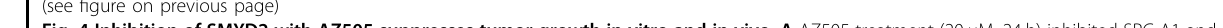
Fig. 4 Inhibition of SMYD2 with AZ505 suppresses tumor growth in vitro and in vivo. A AZ505 treatment (20 μ M, 24 h) inhibited SPC-A1 and GLC-82 cells proliferation, as examined by CCK8 proliferation assay. * p < 0.05; ** p < 0.01; *** p < 0.001; **** p < 0.0001 compared with the control from two-way ANOVA comparisons test. B Migration (would healing) and invasion (Transwell) assays indicated that AZ505 (20 μ M, 24 h) treatment suppressed SPC-A1 and GLC-82 cell migration and invasion. Representative photographs were taken at ×200 magni fi cation. **** p < 0.0001 compared with unpaired T test. Scale bars, 100 μ m. C , D The in vivo xenograft model showed that SMYD2 AZ505 treatment reduced tumor volume and weight compared with the DMSO group. E The in vivo metastasis model showed that the metastatic lesion was signi fi cantly suppressed by the intraperitoneal injection of AZ505 compared to those in the DMSO group. Two-way ANOVA comparisons test was performed on tumor volume. Unpaired T test was performed on tumor weight, *** p < 0.001, **** p <